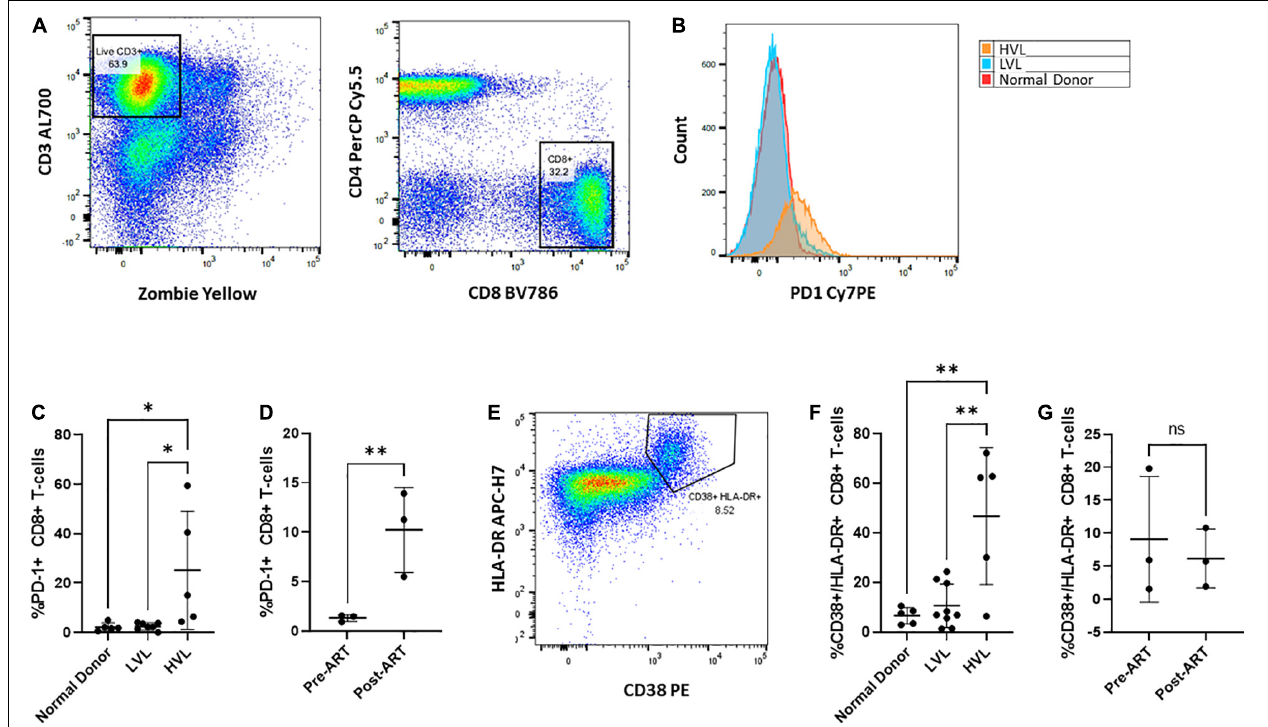
FIGURE 8 | Phenotypic characterization of CD8 + T cells Pre- and Post-therapy. PBMCs from normal, LVL or HVL donors were stained for both T-cell exhaustion using PD-1 and immune activation using HLA-DR and CD38 and analyzed by flow cytometry. (A) Gating strategy for determining the exhausted population of CD8 + T-cells. Following gating to exclude debris and doublets, gates were drawn around live CD3 + T-cells and this population used to identify CD4-/ CD8 + T-cell populations. (B) Comparison between normal donor (red), ART naïve LVL donor (blue), and ART naïve HVL donor (orange) expression of PD-1. (C) Comparison of CD8 + T-cell expression of PD-1 between normal donors ( n = 5), ART naïve LVLs ( n = 7), and ART naïve HVLs ( n = 5) statistical significance was determined by one-way ANOVA, ∗ P < 0.05. (D) A longitudinal evaluation of CD8 + T-cell exhaustion pre- and post- therapy. A comparison of the expression of PD-1 was evaluated for 3 LVL donors both pre-ART and post-ART, ∗∗ P < 0.01. (E) Immune activation was determined by gating CD8 + T-cells that expressed both HLA-DR and CD38. (F) Comparison of CD8 + T-cell expression of HLA-DR and CD38 between normal donors ( n = 5), ART naïve LVLs ( n = 7), and ART naïve HVLs ( n = 5) statistical significance was determined by one-way ANOVA, ∗∗ P < 0.01. (G) A longitudinal evaluation of CD8 + T-cell activation pre- and